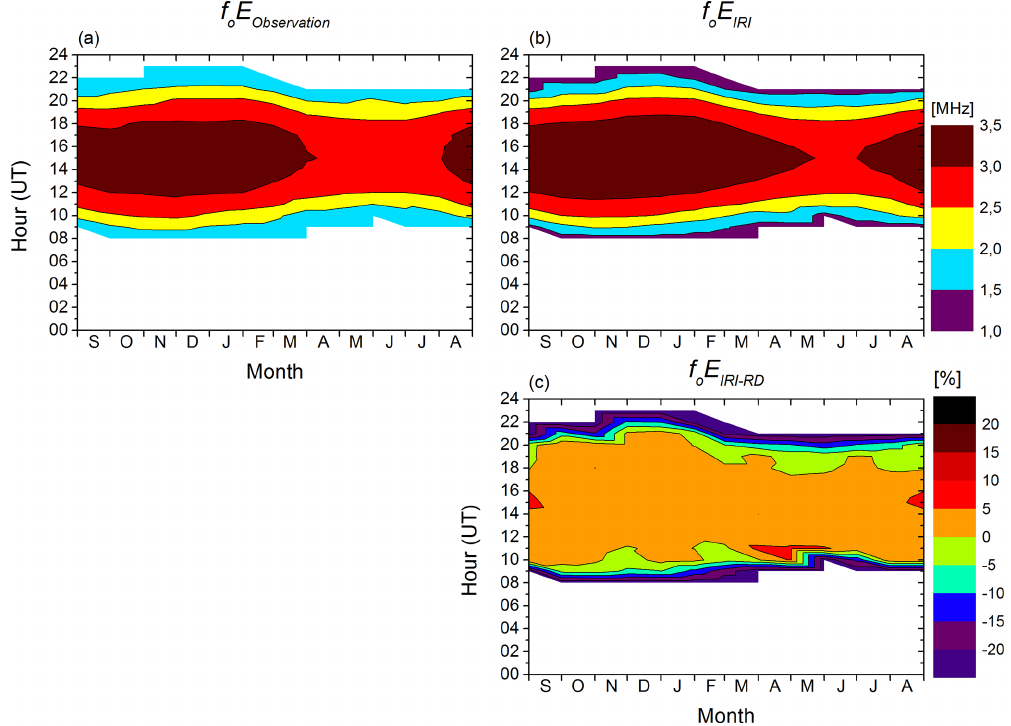
Figure 5. Contour plot of the monthly averaged fo E (a) measured by the Santa Maria digisonde (SMK29), provided by (b) IRI, and (c) the relative deviation ( R D ) in percent.